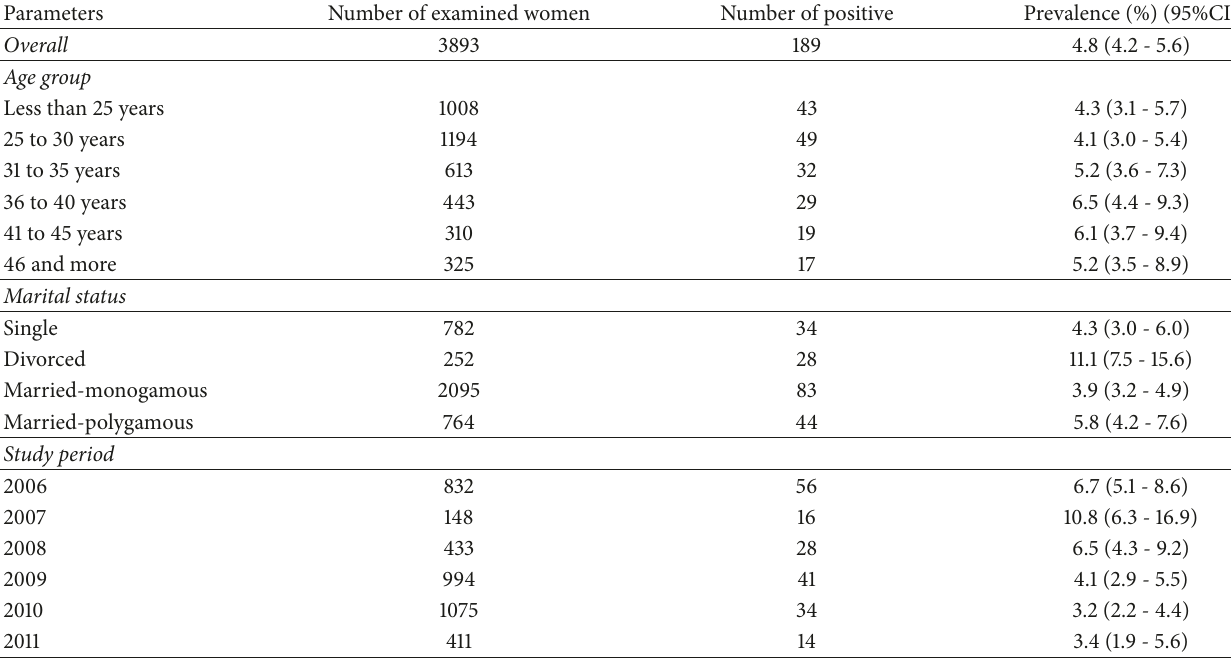
Table 3: Prevalence and distribution of Trichomonas vaginalis infection among the study participants.